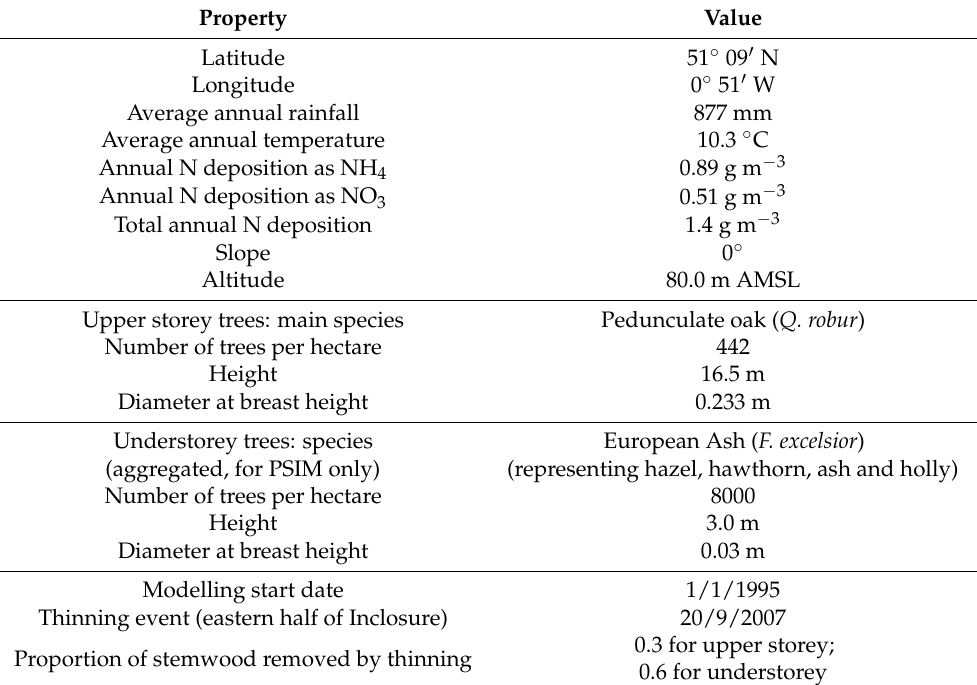
Table 1. Site and vegetation properties in 1995 with average climate and air chemistry data (1995–2014) input to initiate the LandscapeDNDC model specifically for the Straits Inclosure, Alice Holt